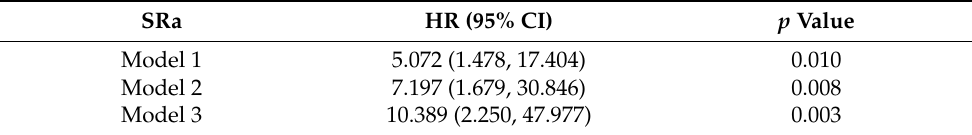
Table 4. Multivariable Cox regression analysis with initial SRa for